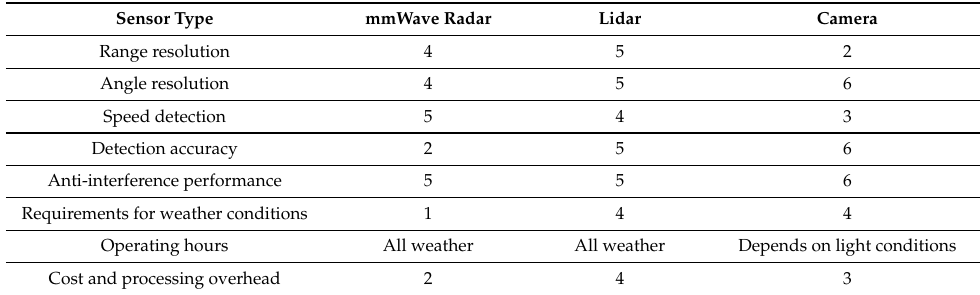
Table 3. Comparison of mmWave radar, lidar, and camera [36–40]. “1”–“6” denote the levels from “extremely low” to “extremely